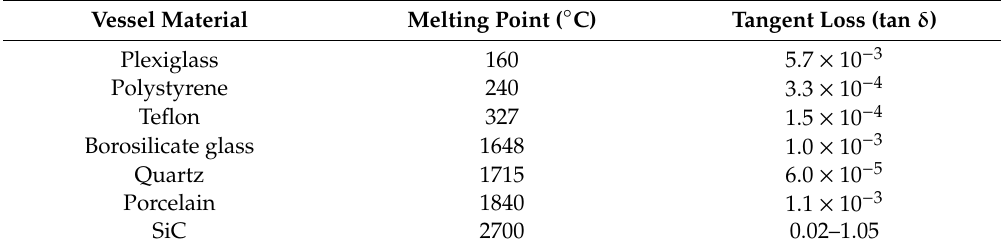
Table 2. Loss tangent values for di ff erent materials applicable for µ